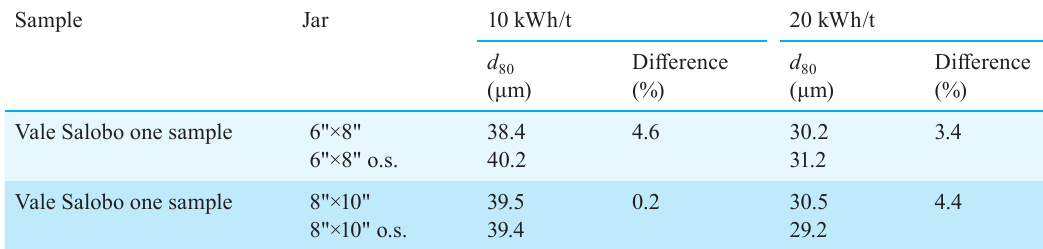
Difference d 80 Difference d 80 (μm) (%) (μm) (%) 6"×8" o.s. 8"×10"